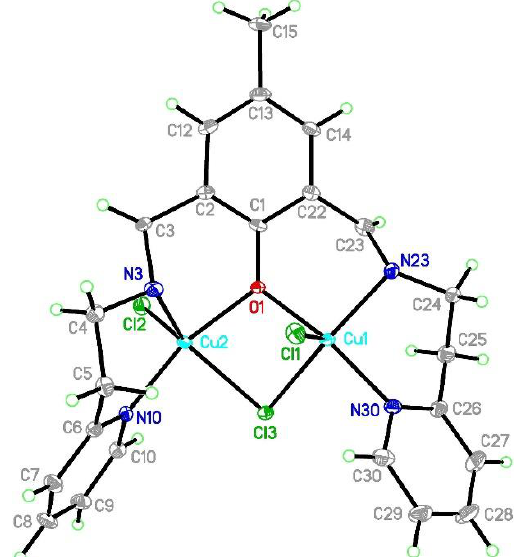
Figure 4. Asymmetric unit of [CuCl 3 (L2)] · 0.5MeCN 2 with the thermal ellipsoids at 50% probability for clarity of the picture. The partially occupied acetonitrile molecule is omitted.